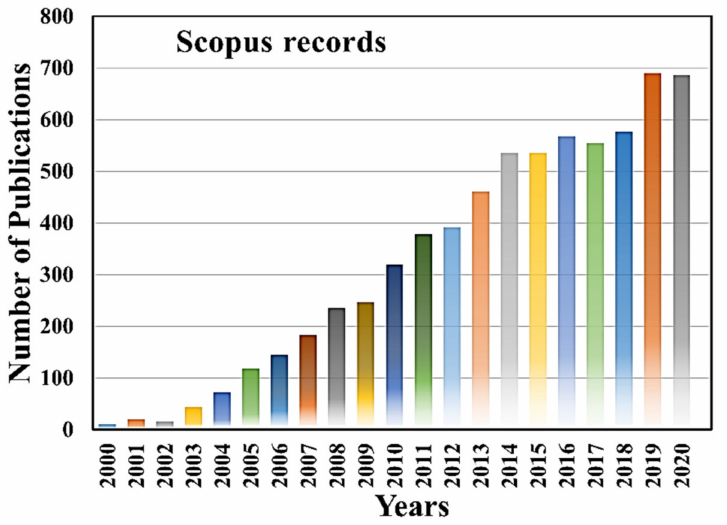
Figure 1. Year-wise microfluidic single cell scientific article publication. The data are adapted from Scopus records until